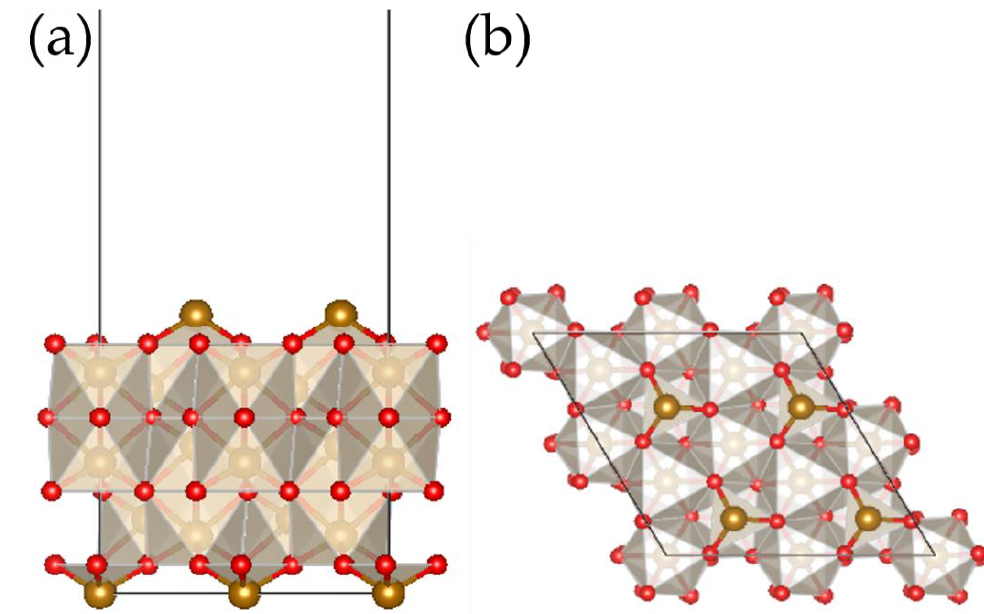
Figure 1. Specularite Fe 2 O 3 (0 0 1) surface: ( a ) front view, ( b ) vertical